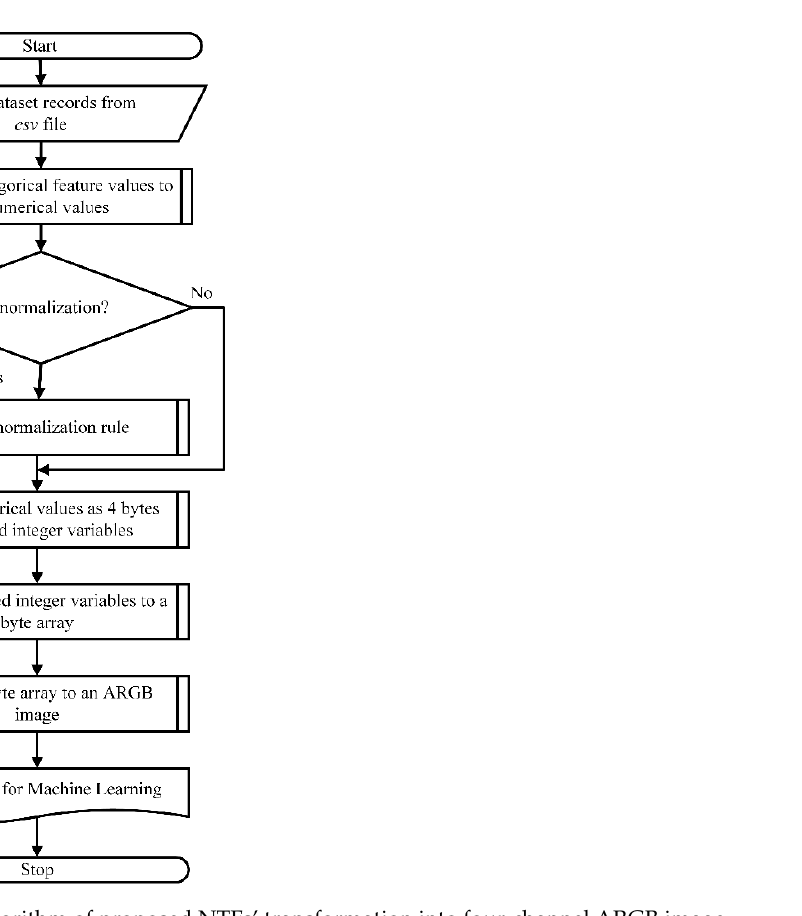
Figure 4. Algorithm of proposed NTFs’ transformation into four-channel ARGB image.